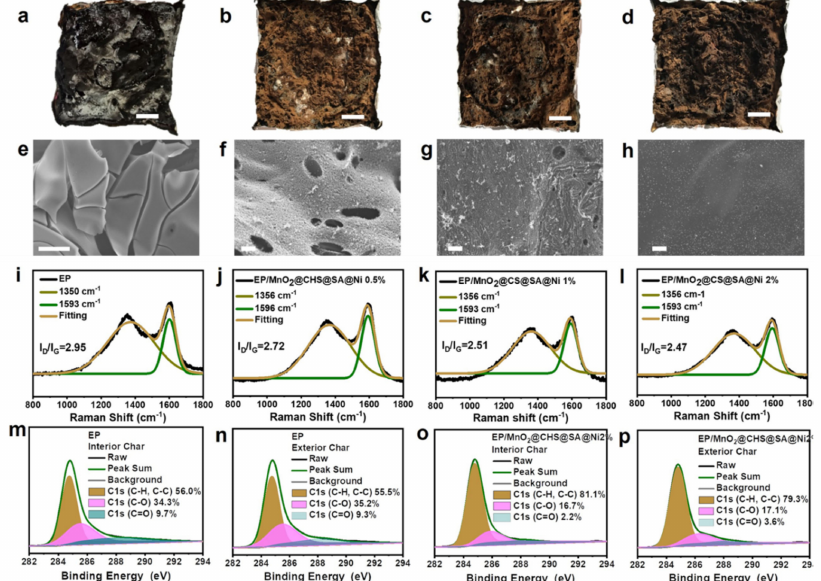
Figure 6. Char residue analysis of epoxy composites. ( a – d ) Digital images (the insert scale bar is 2 cm), ( e – h ) SEM images (the insert scale bar is 40 µ m) and ( i – l ) Raman results of char residues for pristine EP, EP/MnO 2 @CHS@SA@Ni 0.5%, EP/MnO 2 @CHS@SA@Ni 1% and EP/MnO 2 @CHS@SA@Ni 2% and ( m – p ) the high-resolution C1s spectra of interior and exterior char residues for pristine EP and EP/MnO 2 @CHS@SA@Ni 2% after cone calorimeter